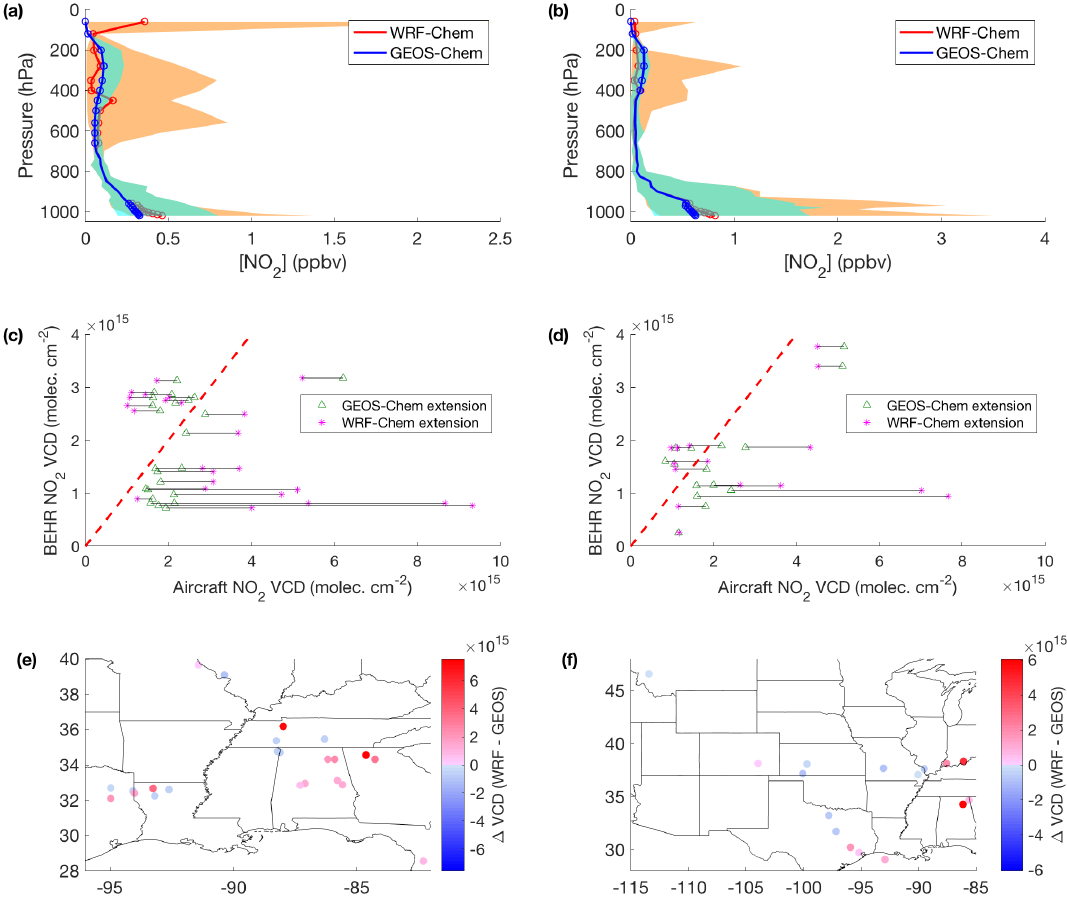
Figure 7. (a, b) The profiles used to calculate the aircraft VCDs extended using WRF-Chem or GEOS-Chem profiles; the solid line is the median of all profiles, and the shading represents the 10th and 90th percentiles for each binned level. Circles indicate levels that were derived from the models in at least 50% of the profiles. (c, d) Comparison of BEHR v3.0 (D) VCDs vs. aircraft-derived VCDs using GEOS-Chem and WRF-Chem profiles to extend the profile to the surface and tropopause. The black lines connect corresponding comparisons between the two methods and the red dashed line represents the 1 : 1 agreement. (e, f) Difference between aircraft VCDs extended with WRF-Chem and GEOS-Chem profiles. Panels (a, c, e) are for the SENEX campaign, and (b, d, f) are for